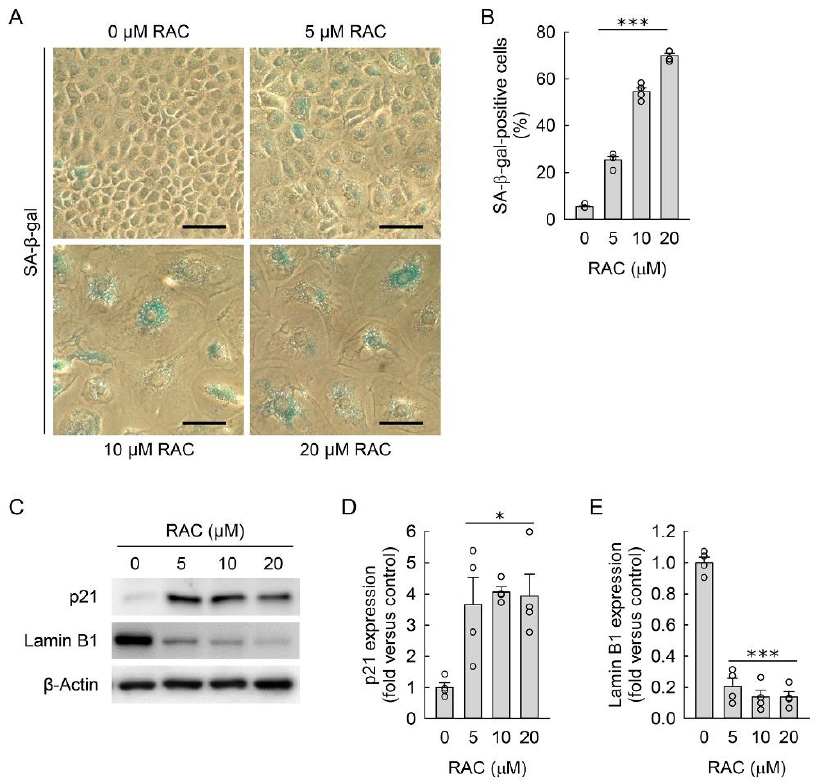
Figure 3. Repeated administration of cisplatin (RAC) induces cellular senescence in kidney fibroblast cells. Normal rat kidney fibroblast NRK-49F cells were treated with 0, 5, 10, or 20 μM cisplatin in normal culture media for 6 h, and the media were replaced with normal culture media, followed by incubation for 18 h. The experiment was repeated three times, and finally the cells were harvested at 72 h after the first treatment. ( A ) Representative images of senescence-associated β -galactosidase (SA- β -gal)-stained cells at ×400 magnification using the Olympus IX70 inverted microscope (Olympus, Tokyo, Japan), DP Controller camera (Olympus), and DPManager imaging software (Olympus). Scale bar, 50 μm. ( B ) The percentage of SA- β -gal-positive cells was counted at × 200 magnification ( n = 4 experiments). ( C ) Representative Western blots of p21 and lamin B1 expression. Anti- β -actin antibody was used as a loading control of Western blot analysis. ( D , E ) Quantifications of p21 and lamin B1 expression using the Azure c300 imaging system (Azure Biosystems, Dublin, CA, USA) ( n = 4 experiments). ( B , D , E ) Data are presented as mean ± standard error of the mean with individual data points. Statistical significance was determined by one-way analysis of variance fol- lowed by Tukey’s post hoc test (( B ) F 3,12 = 496.935, p < 0.001; ( D ) F 3,12 = 6.457, p = 0.008; ( E ) F 3,12 = 98.019, p < 0.001). * p < 0.05, *** p < 0.001 versus 0 μM RAC.